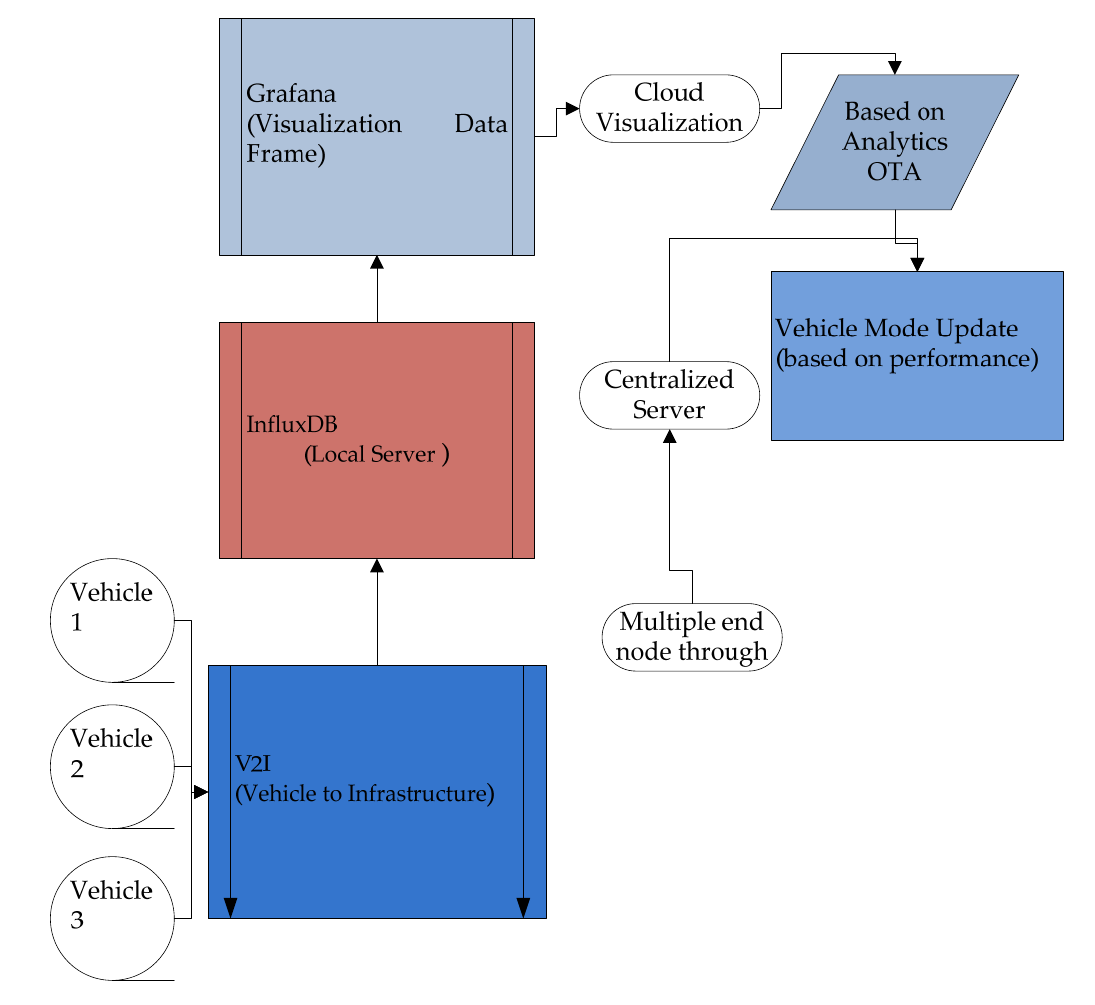
Figure 3. IoT functional flow diagram.